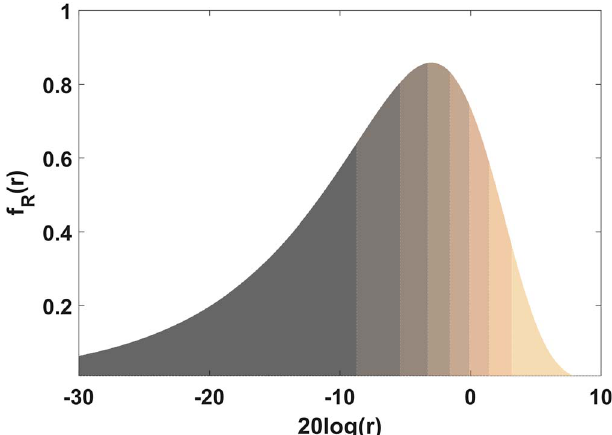
Fig. 9. Example of equally probable partition of probability density function used in the chi-square